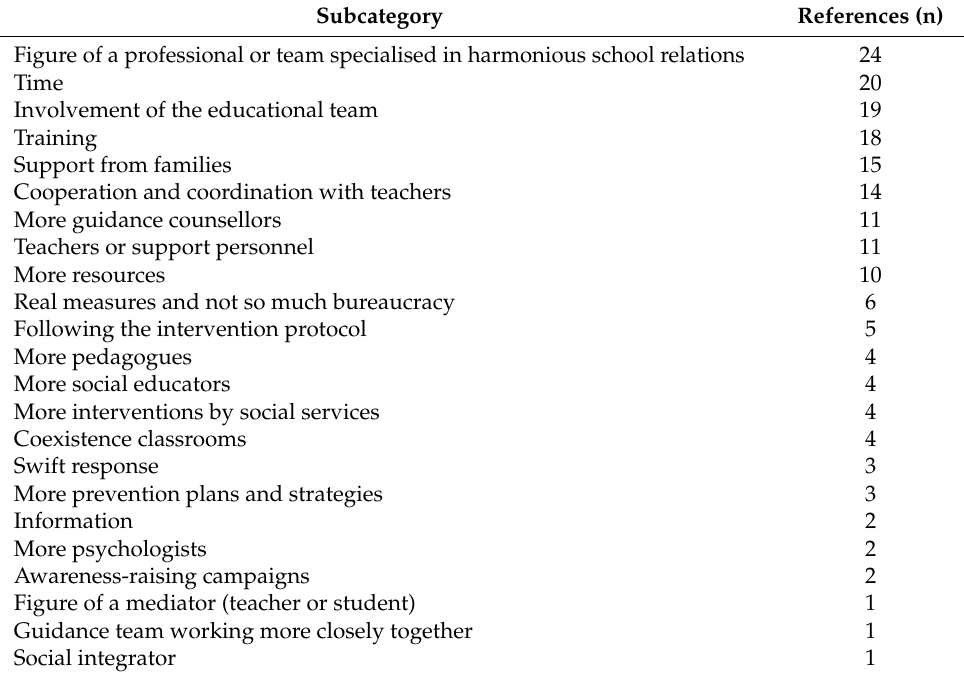
Table 9. Analysis of category 4. Support for addressing conflicts.